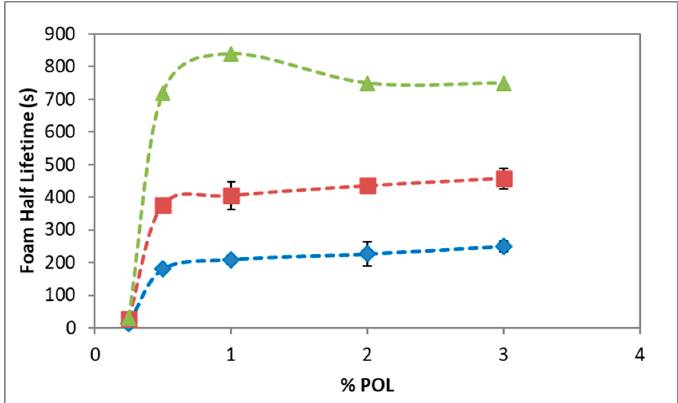
Figure 2. Foam half lifetime of foaming solutions of polidocanol (POL; blue rhomboids), POL + hyaluronic acid (HA) 0.3% (red squares), and POL + Pluronic-F68 (F68) 0.1 mM (green triangles). Foam samples were produced with the double syringe method standardized protocol (1:4 liquid / air, 50 cycles, 0.9% NaCl, and 20 ◦ C). Values plotted are mean values of three independent measurements, and standard deviations according to statistical tools showed significant di ff erences between all samples ( p < 0.05). Lines are a guide for the eye.